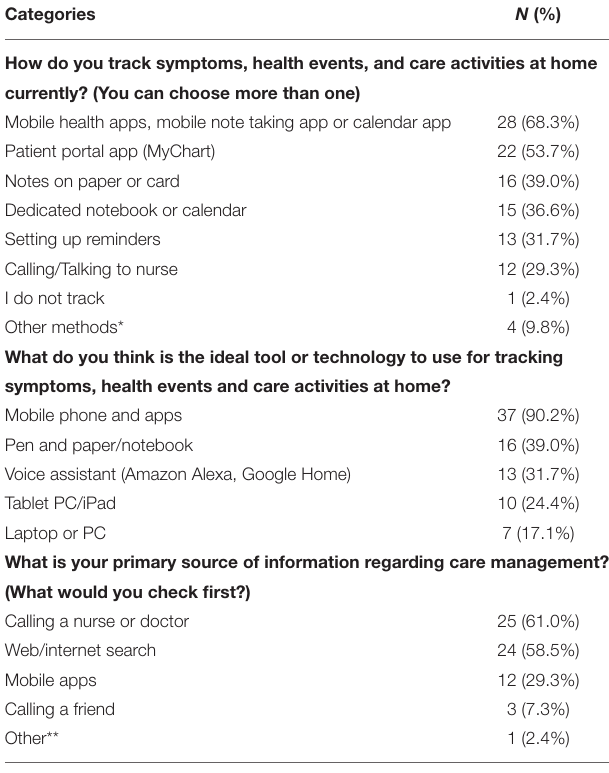
TABLE 3 | Technology interaction in symptoms tracking symptoms, health events and care activities ( n =